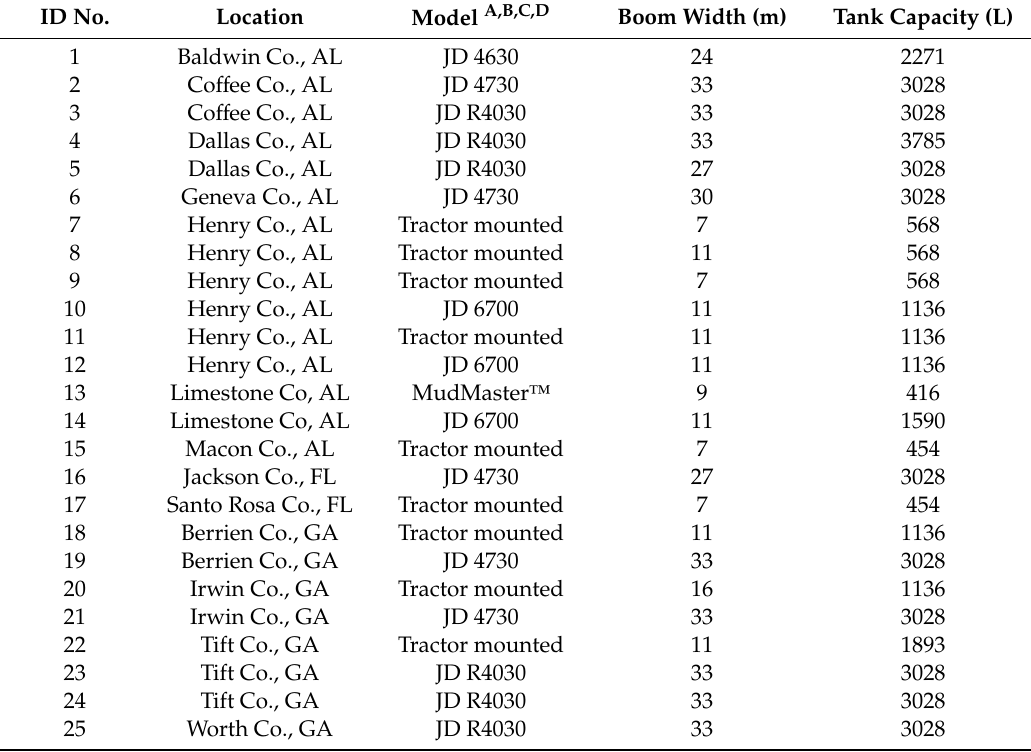
Table 2. Sprayer ID, model, boom width, and tank capacity for sprayer